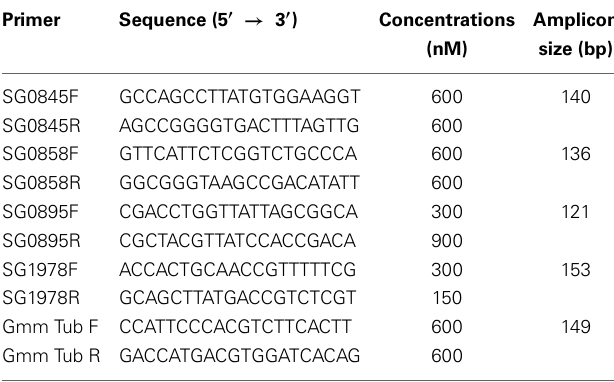
quantitative PCR